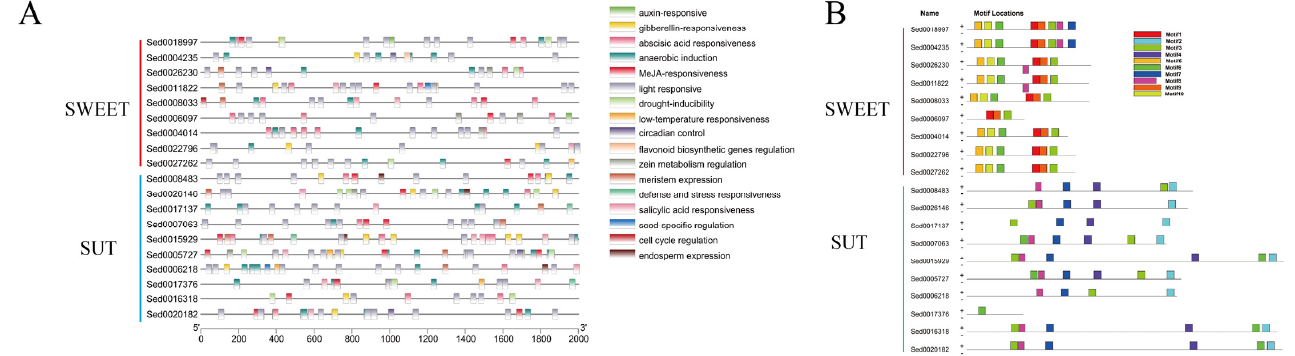
Figure 7. Cis-acting elements analysis ( A ) and protein conserved motif ( B ) of SWEET and SUT genes.